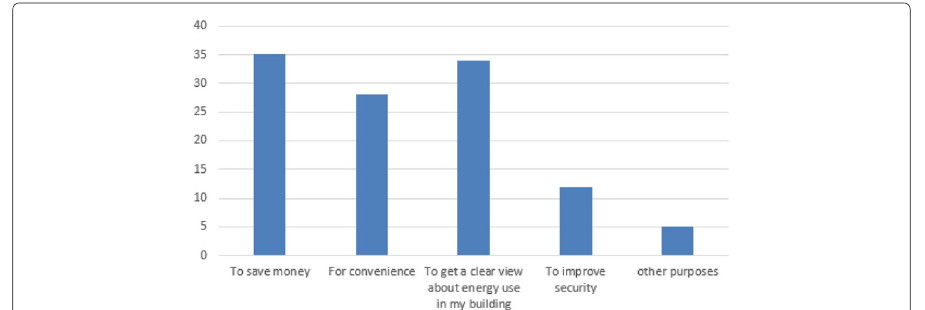
Fig. 33 Purposes of using the BOS UI as stated by the test